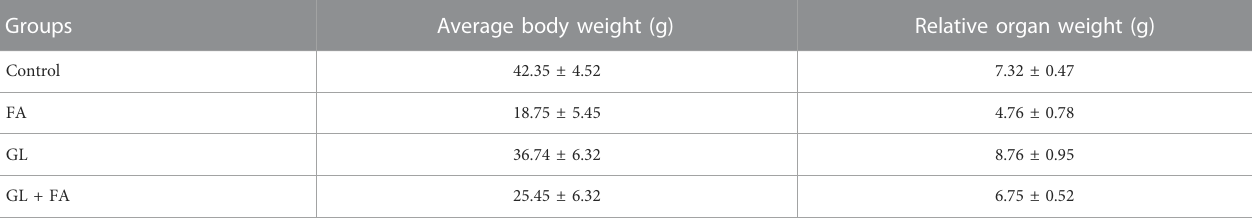
TABLE 8 Effects of G. lucidum and formaldehyde on the mean body weight and relative organ weight of rats.